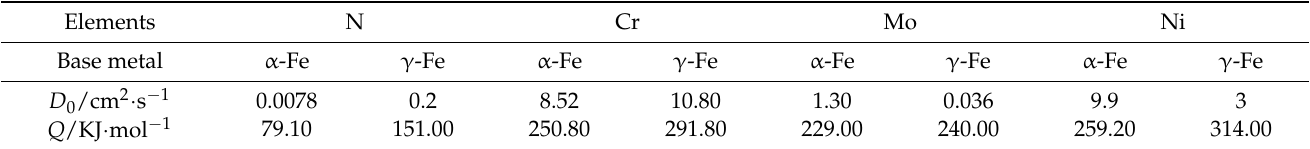
Table 5. D 0 and Q of different elements in S32750 duplex stainless steel.